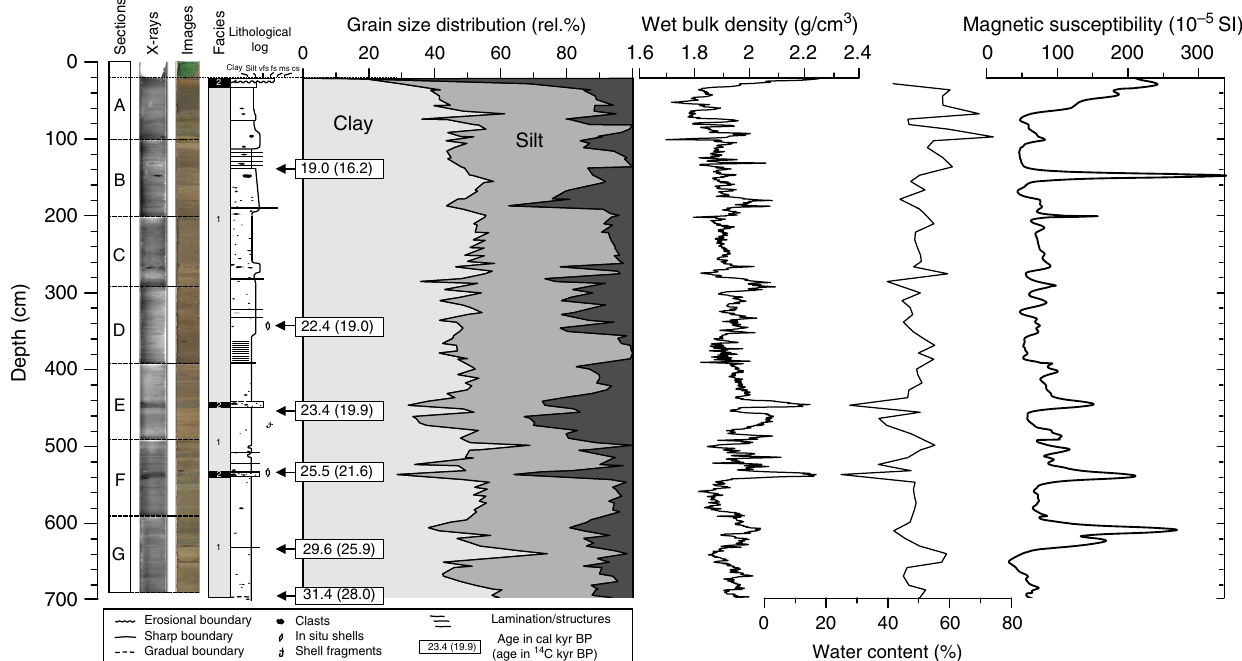
Fig. 2 Sedimentological and physical properties of GS14-190-01PC (20 – 700 cm). Available calibrated radiocarbon AMS 14 C datings (uncalibrated ages in parenthesis) are displayed (Table 1)